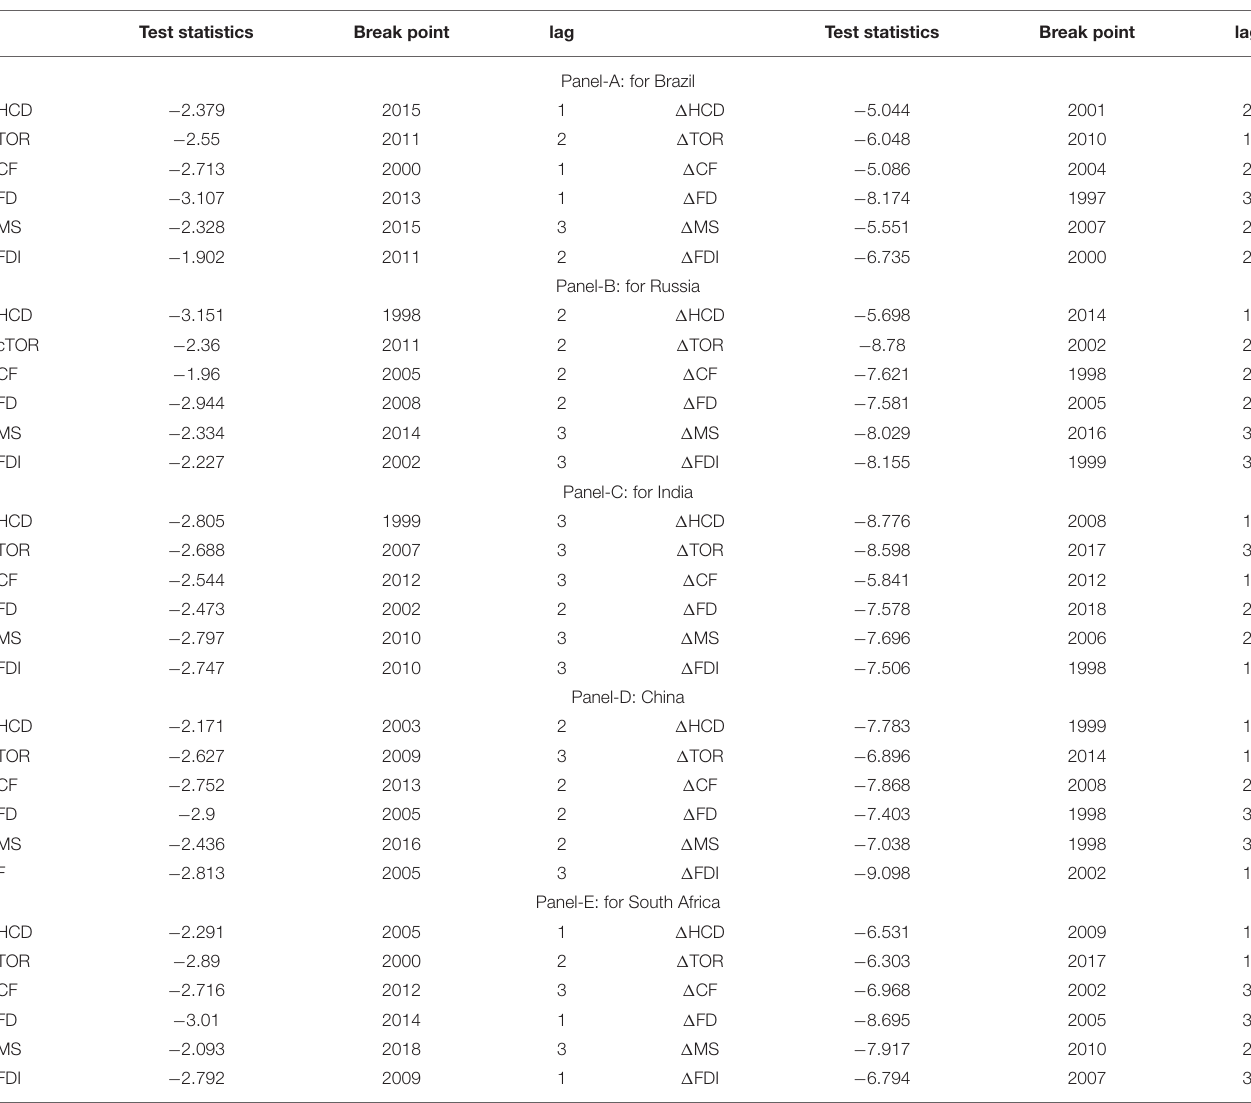
TABLE 4 | Results of unit root test with an unknown structural break. Test